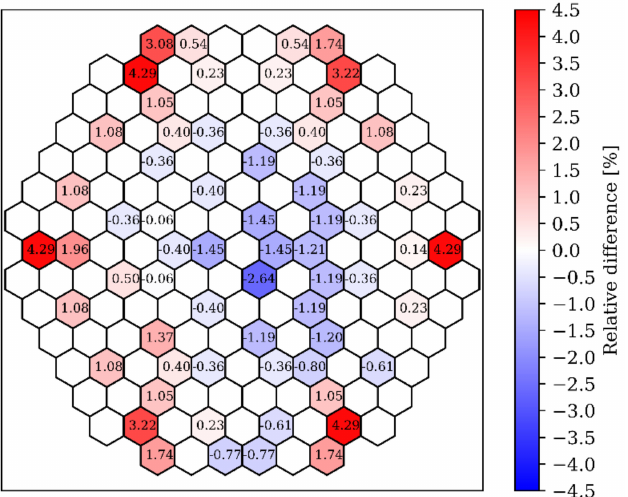
Figure 24. Relative radial power difference of PARCS compared with